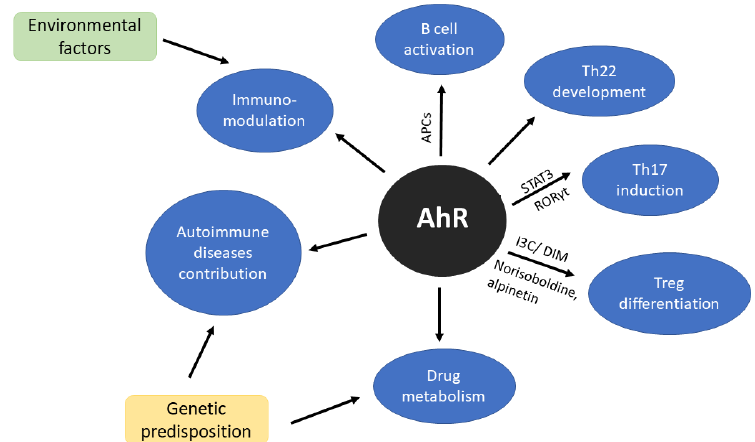
Figure 1. Scheme of aryl hydrocarbon receptor (AhR) significance in immune system. AhR as a sensor of environmental factors affects immunomodulation. Additionally, genetic compound may trigger the mechanisms of autoimmune diseases development and treatment response.